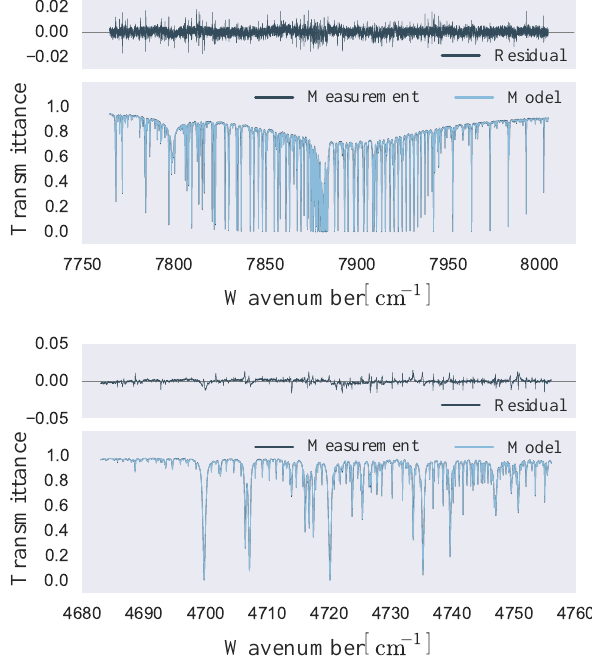
Figure 4. Same as Fig. 2 but using the GGG2014 higher-order con- tinuum fit option. For O 2 (upper panel) N = 5 was applied while for N 2 O (lower panel) N = 3 was used.